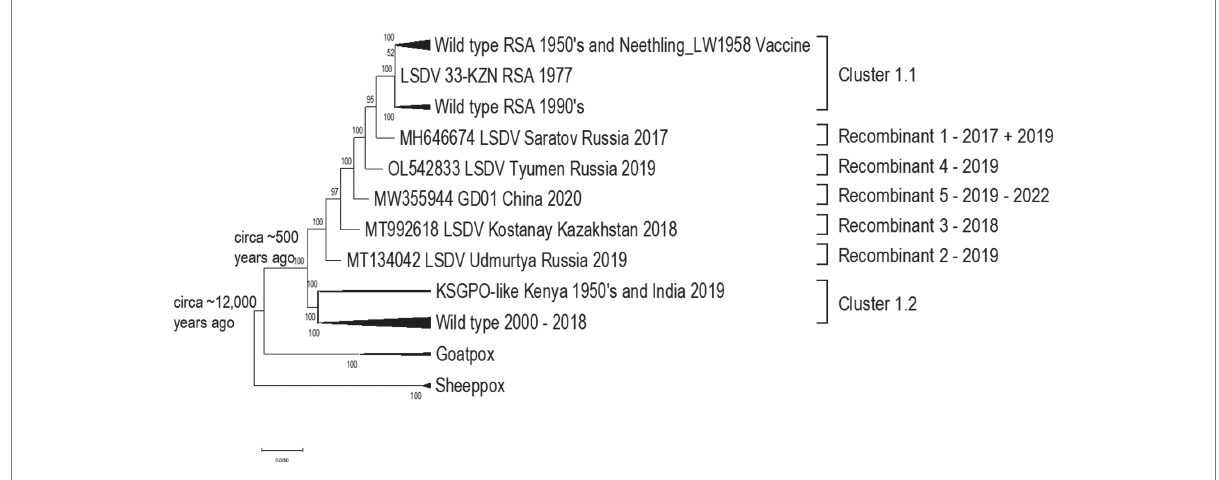
FIGURE 2 Phylogenetic comparison using a Maximum likelihood tree, under GTR model with 100 Bootstrap iterations, to indicate the relatedness of the